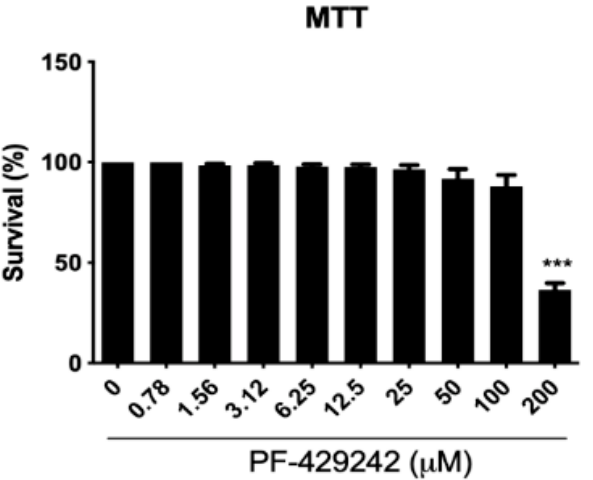
Figure 4. Cytotoxicity of PF-429242 in mammalian cells. Peritoneal macrophages from BALB/c mice were treated with different concentrations of PF-429242 for 72 h at 37 °C. Cytotoxicity was evaluated by MTT assays. Graphs represent the percentage of viable macrophages after treatment. Statistical analysis by one-way ANOVA followed by Tukey’s post-test was performed. Experiments were performed in triplicate and graphs are representative of three independent experiments. *** p < 0.001.